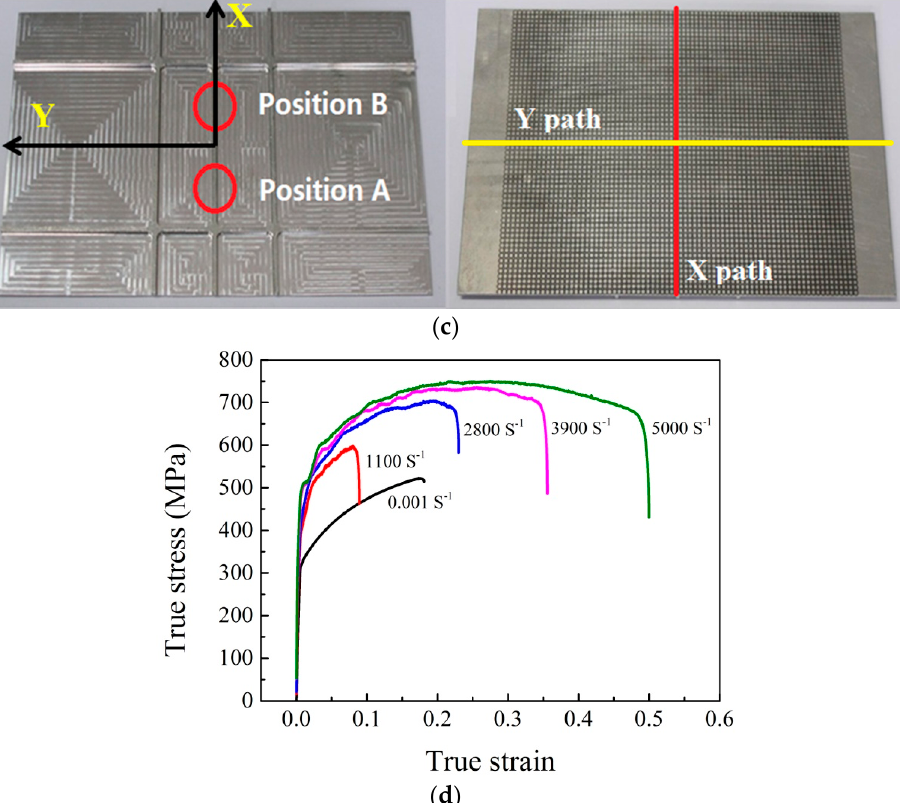
Figure 1. The information of the panels: ( a ) sizes (mm) and different ribs; ( b ) deformed panels with different rib-styles; ( c ) the defined paths of the web; and ( d ) the stress-strain data of 2A12-T4 aluminum alloy.